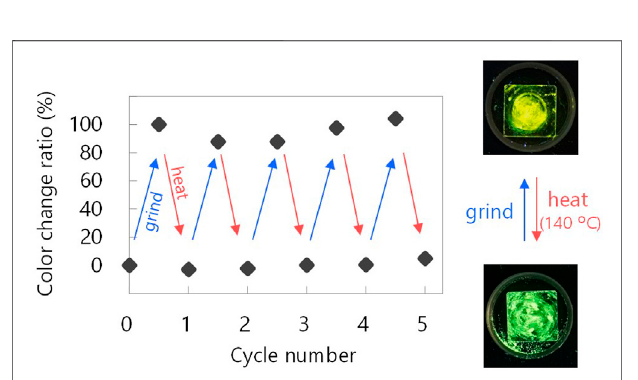
FIGURE 5 | Showing reversibility of the mechano/thermoresponsive RTP chromism of ClTn . Photographic images were acquired under UV light (365 nm). See Experimental Section for de fi nition of the color change ratio.